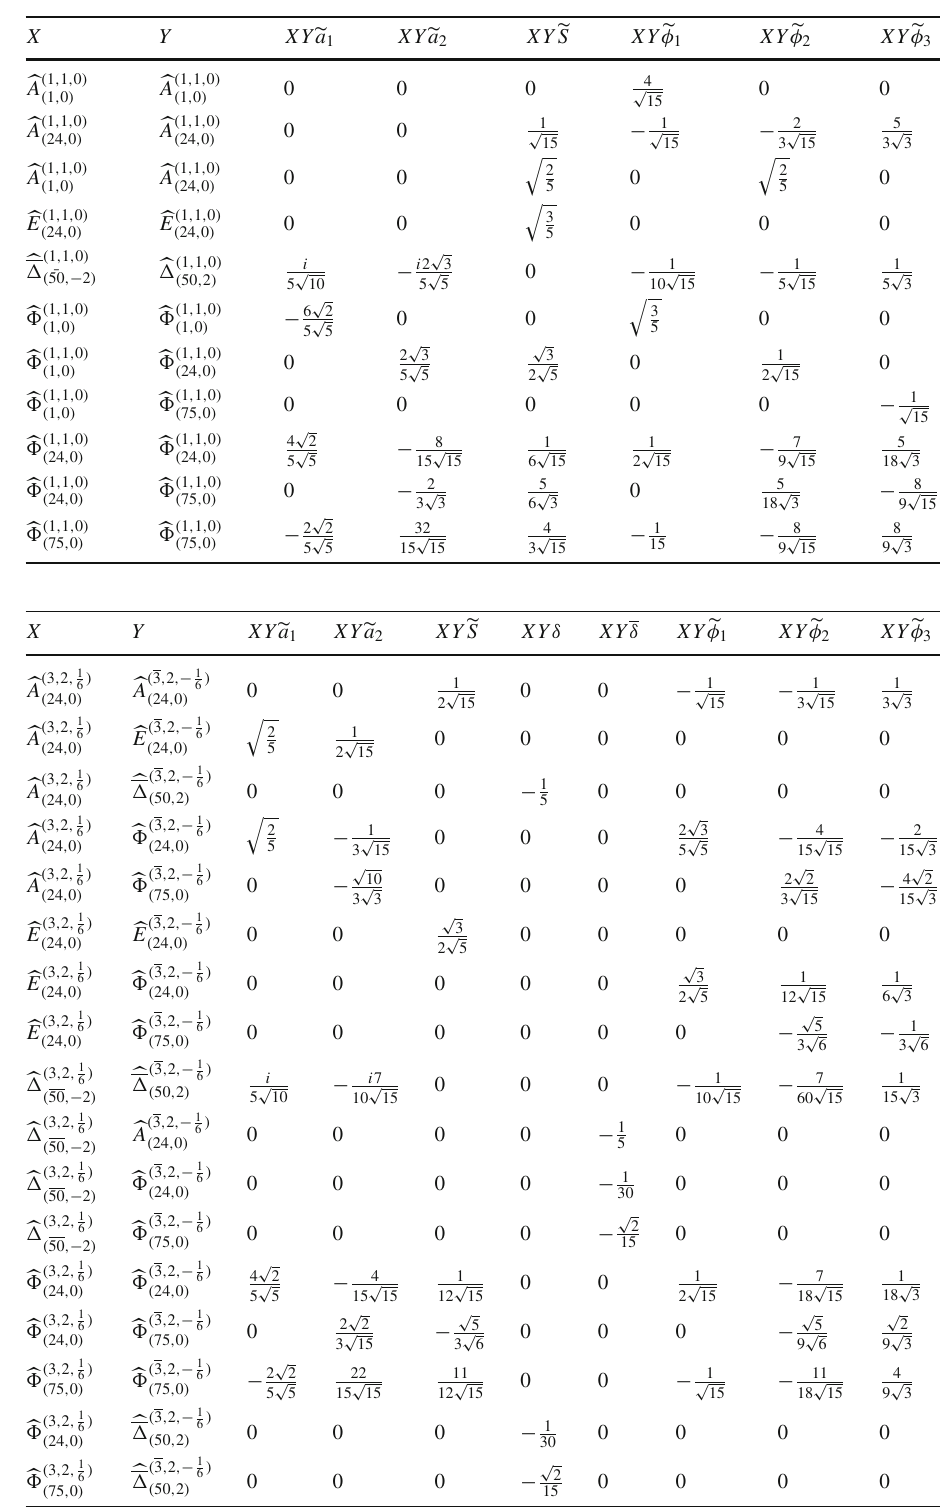
Table 7 CGCs for the SM singlets (1, 1, 0) through G 51 . Here, for example, (cid:23) φ 3 stands for (cid:15) (cid:7) ( 1 , 1 , 0 ) (